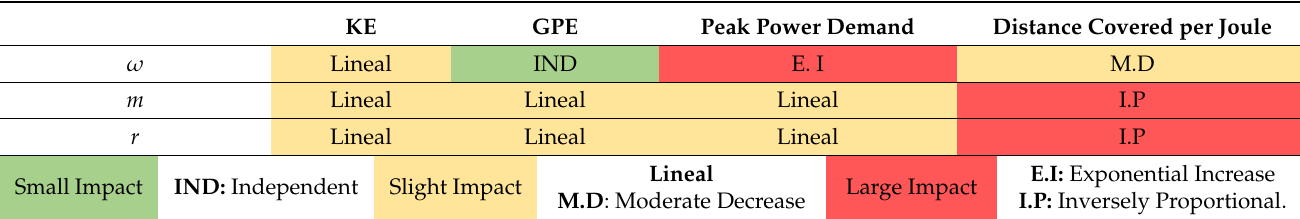
Table 3. Angular velocity, mass, and leg radius effect on KE, GPE peak power demand and the distance covered per joule. KE GPE Peak Power Demand Distance Covered per Joule ω Lineal IND E. I